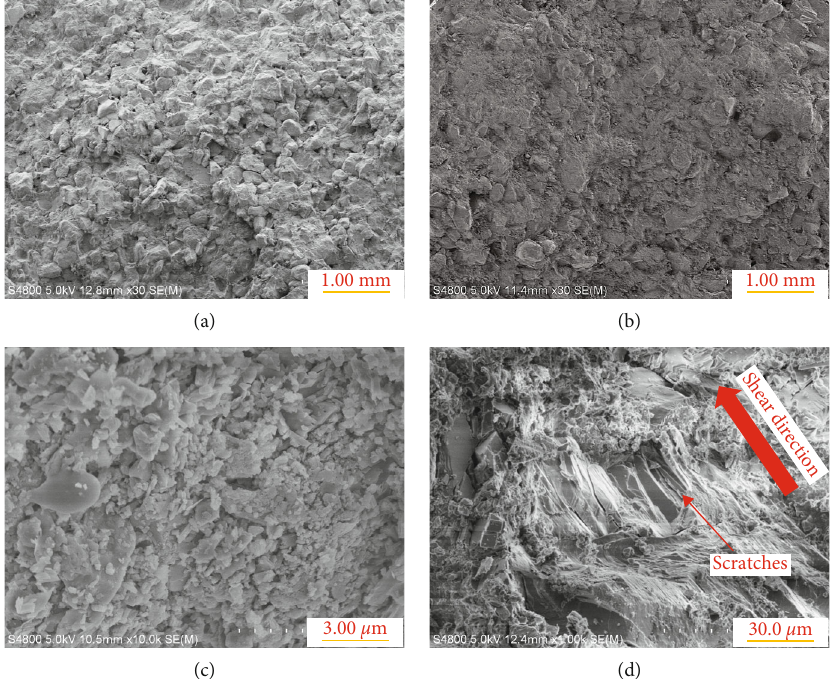
Figure 10: Scanning morphology of joint surface before and after shear tests: (a) and (b) morphological characteristics of the particles before and after shear tests, respectively; (c) and (d) residual gouge and scratches on the shear surfaces, respectively.